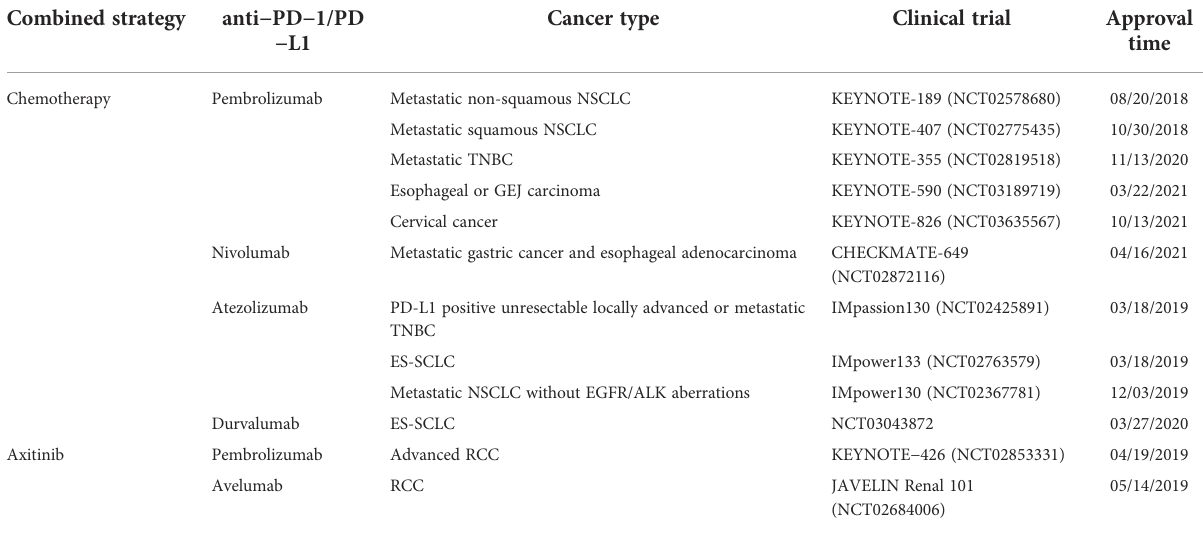
TABLE 2 Approved combination strategies with the PD-1/PDL1